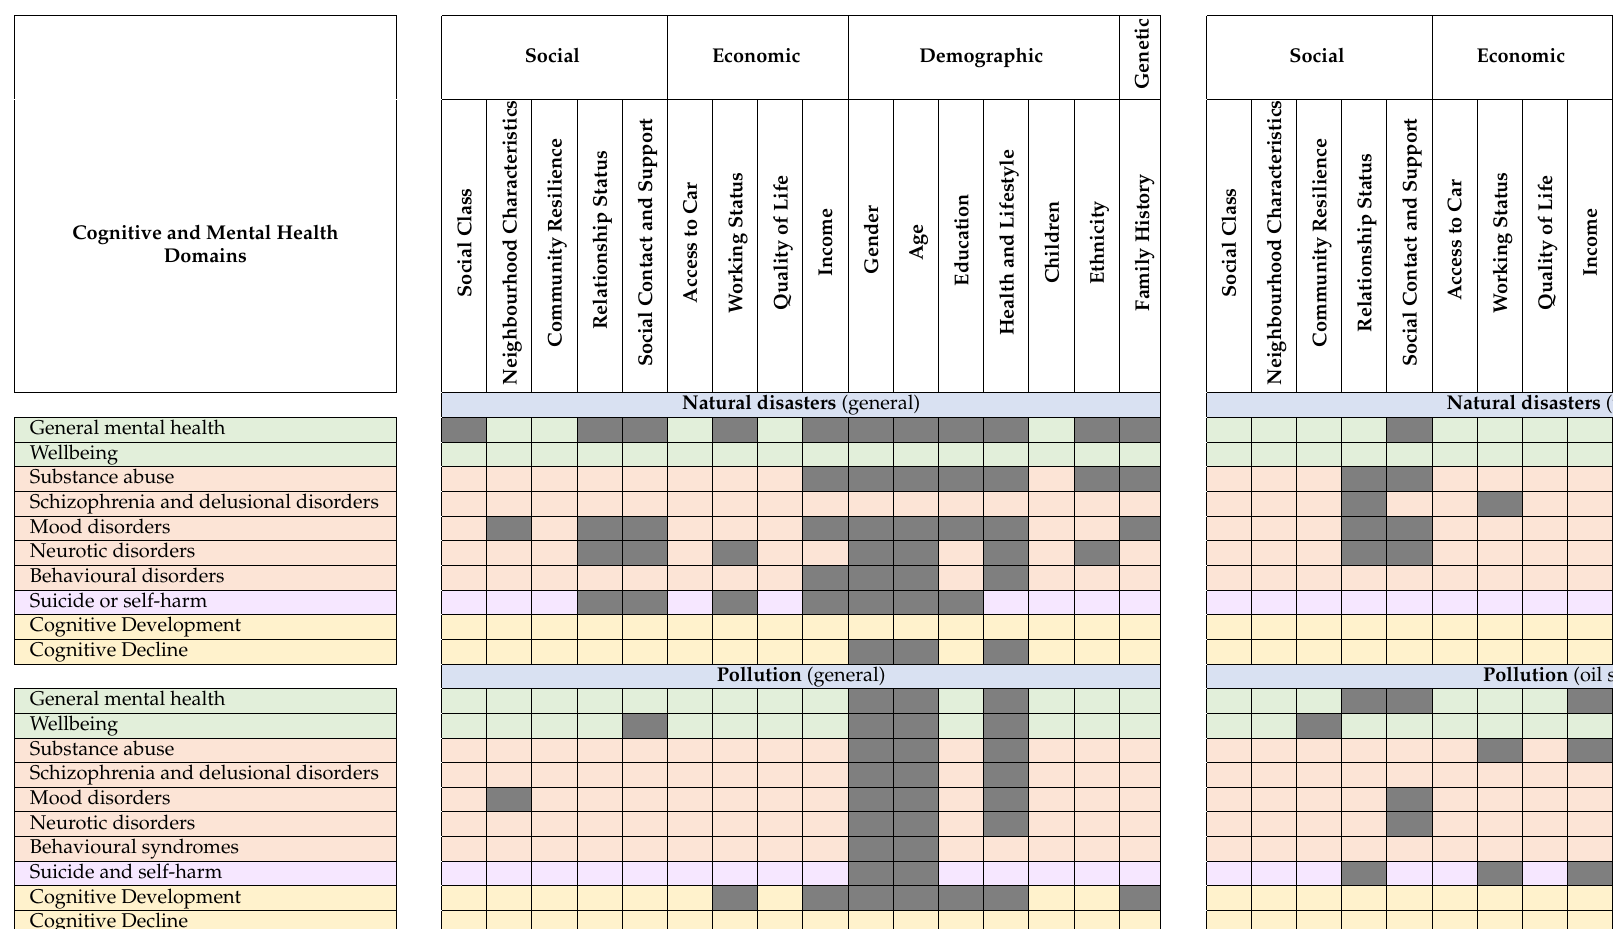
Table 8. Additional determinants are considered in studies by environmental science theme and mental health area. Colours indicate mental health area groupings; dark grey squares indicate where determinants have been used. Note that because they have been subject to recent reviews, climate change, flooding, air pollution, and urban green space are not considered here but have been described in the